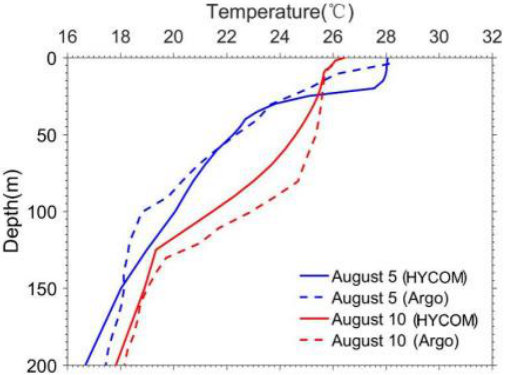
Figure 8. Comparison of temperature profiles obtained from HYCOM data (solid line) and Argo observations (dashed line).